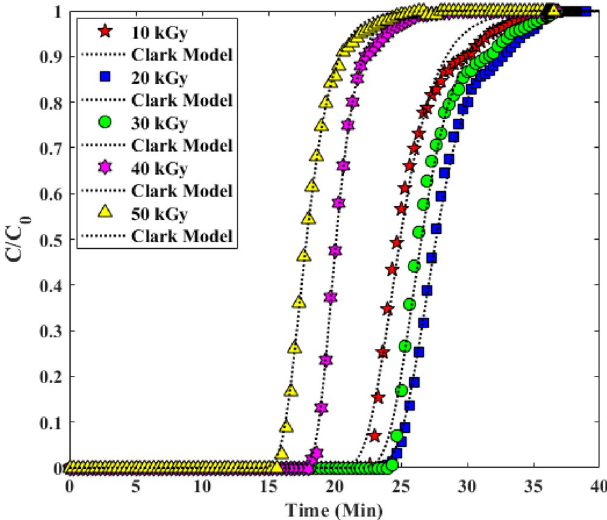
Figure 11. Investigation of Experimental Breakthrough curves in columns with Clark model.